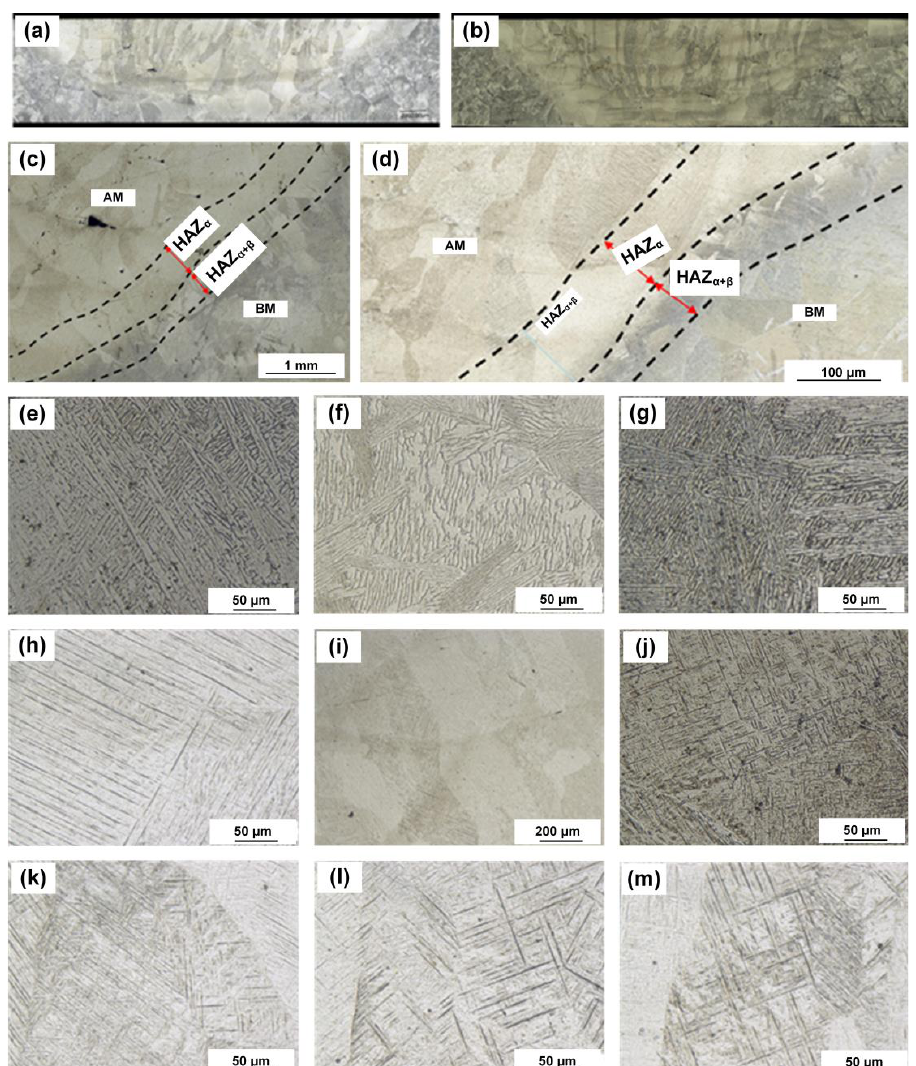
Figure 14. Microstructure comparison for the samples under different repaired layers: ( a ) three repaired layers, ( b ) five repaired layers, ( c ) HAZ width under three repaired layers, ( d ) HAZ width under five repaired layers, ( e ) Basketweave microstructure at HAZ, ( f ) Pristine lamellar α phase and intercrystalline β phase at HAZ, ( g ) Cluster structures at HAZ, ( h ) Needle martensite at HAZ, ( i ) Columnar grain at repairing zone, ( j ) Widmannstatten structure at repairing zone, ( k ) Widmannstatten structure at bottom region, ( l ) Widmannstatten structure at middle region, ( m ) Widmannstatten structure at top region.